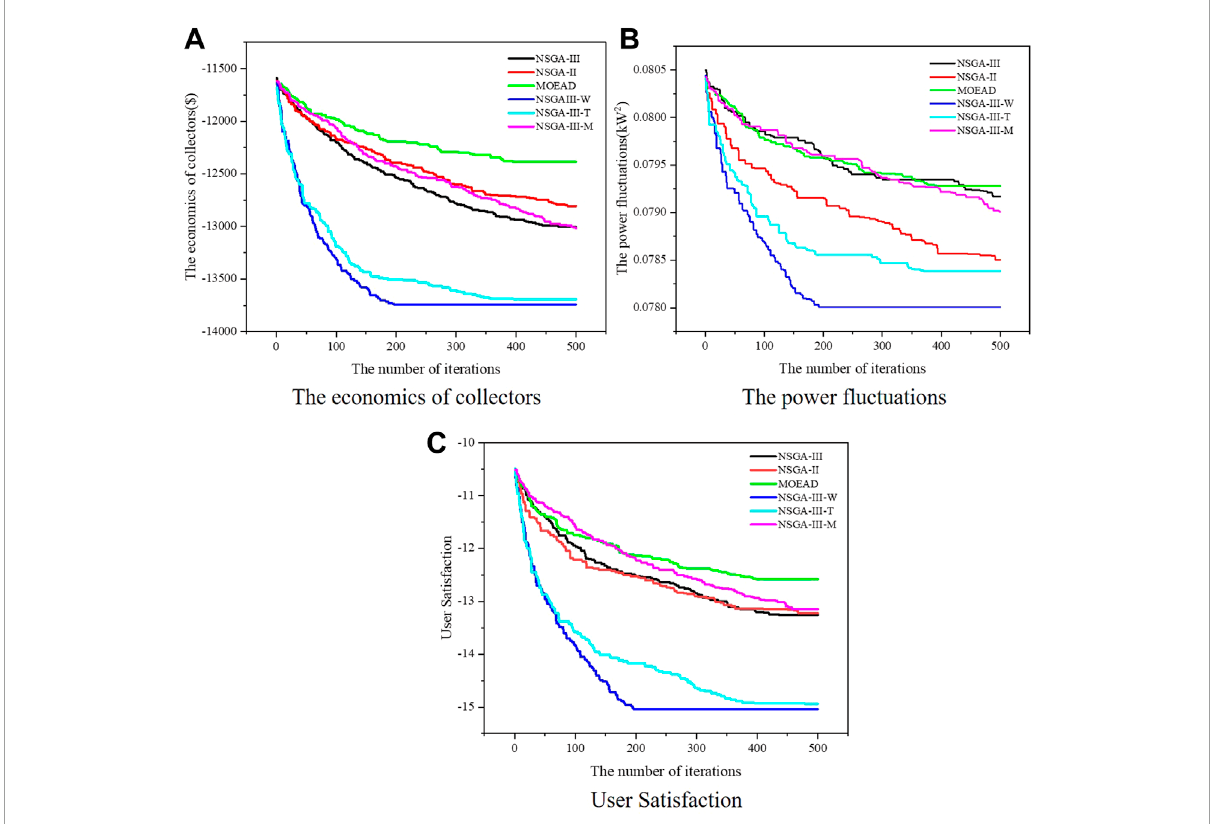
Figure 4 , respectively. The parameter information of different algorithms is listed in Table 1 . In addition, the load requirements of the microgrid system except for electric vehicle users are shown in Table 2